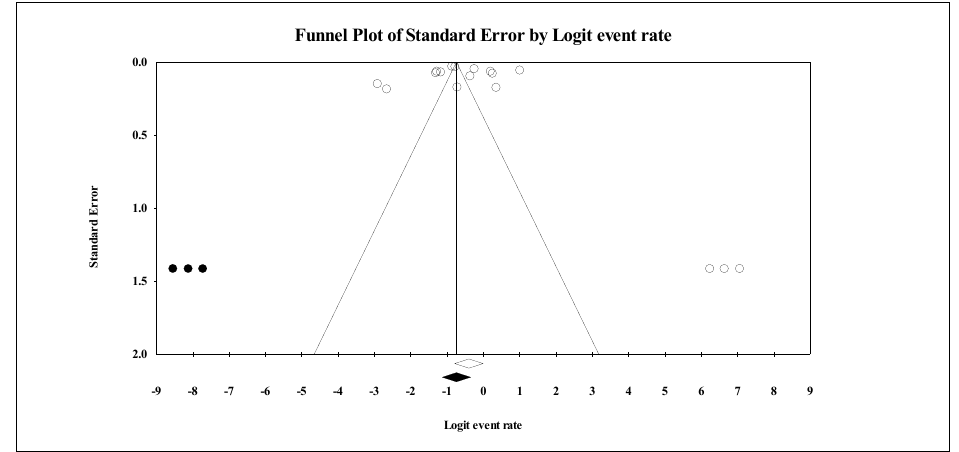
Figure A8. Funnel plot for studies on the prevalence of stress (Egger test: P = 0.69; Begg test: P = 0.86). The vertical solid line represents the summary effect estimates.